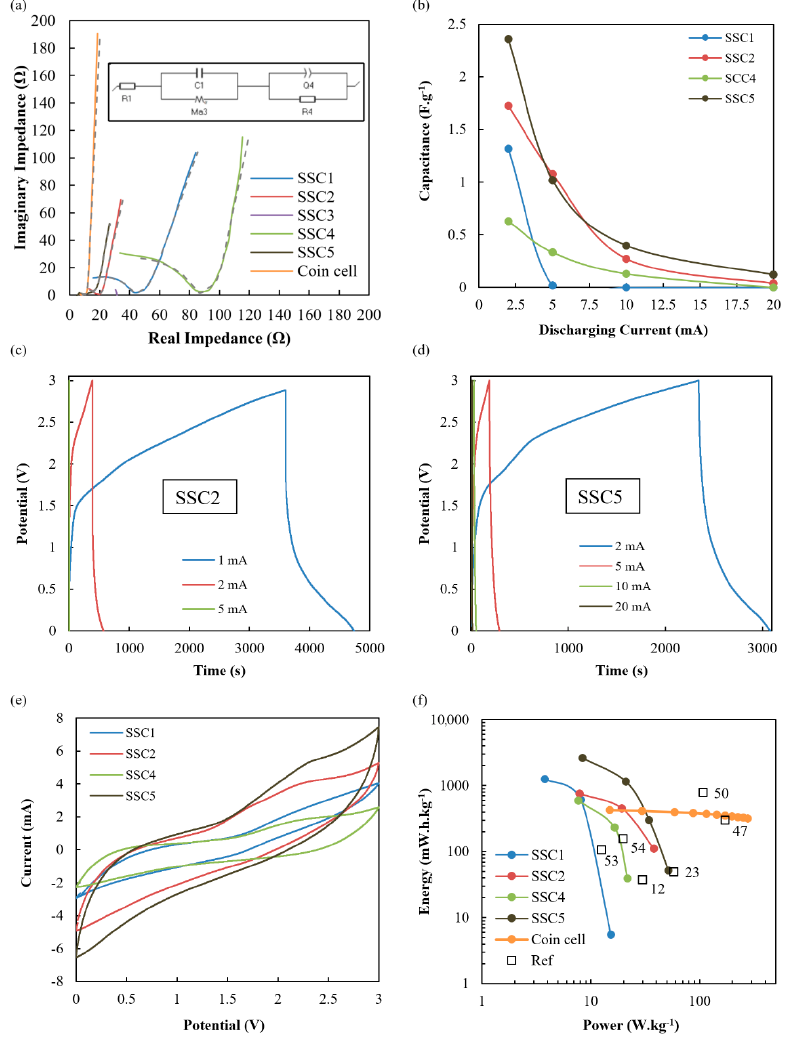
Figure 6. Electrochemical performance of SSC cores normalised to the device mass of the activated SSC core including electrode, separator, ionogel and electrolyte; ( a ) EIS from 100 mHz to 1 MHz with inset equivalent circuit and grey dashed lines for the equivalent circuit fits, ( b ) GCD capaci- tance vs. discharge rate, increasing current GCD of ( c ) SSC2 and ( d ) SSC5, ( e ) cyclic voltammogram at 10 mV s − 1 , and ( f ) Ragone plot including SSC and 2023 coin cell results in comparison with high-performance composite SSCs in literature [12,23,47,50,53,54].